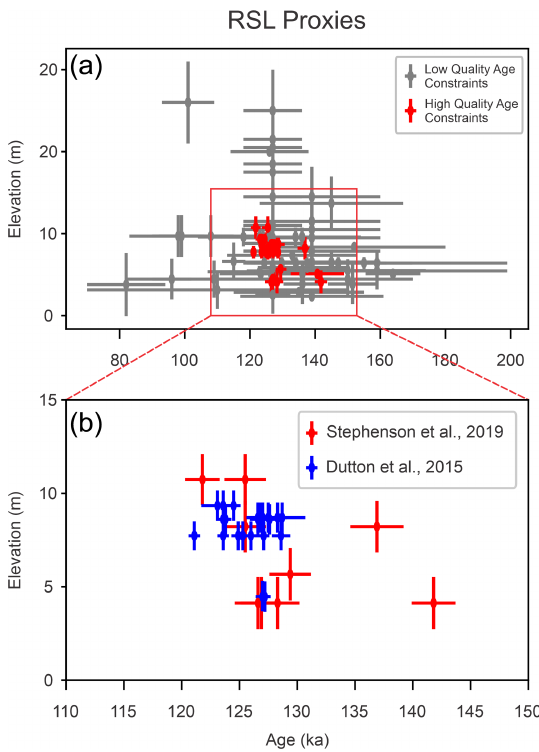
Figure 3. (a) Overview of age and elevation distribution of RPSLs of the East Africa and Western Indian Ocean region. Proxies with age constraints with a quality rating lower than 4 within WALIS are colored grey, and those proxies with a quality rating of 4 or greater are colored red. The elevations refer to paleo relative sea level. “Relative” means that they are still uncorrected for any post- depositional vertical movement, such as tectonics or glacial isostatic adjustment (GIA). (b) The high-quality age constraints are from two areas, northern Madagascar (Stephenson et al., 2019) and the Granitic Seychelles (Dutton et al.,